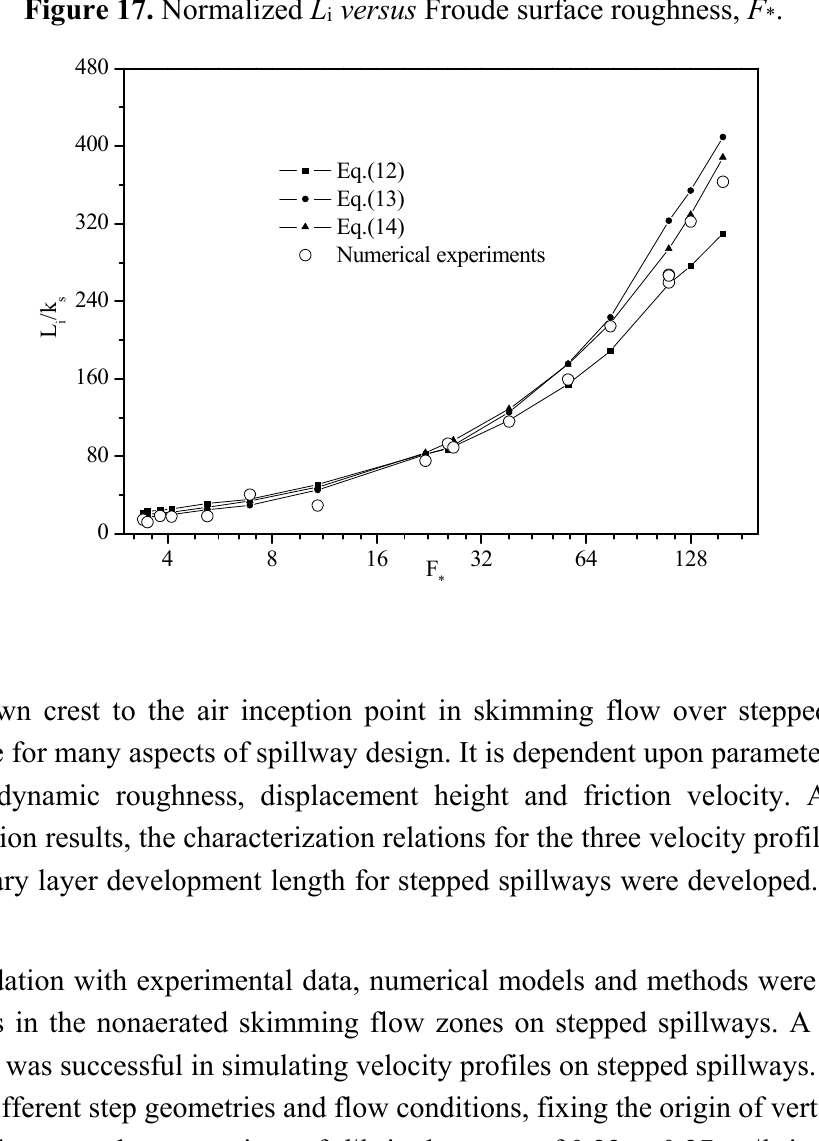
Figure 17. Normalized L i versus Froude surface roughness, F *